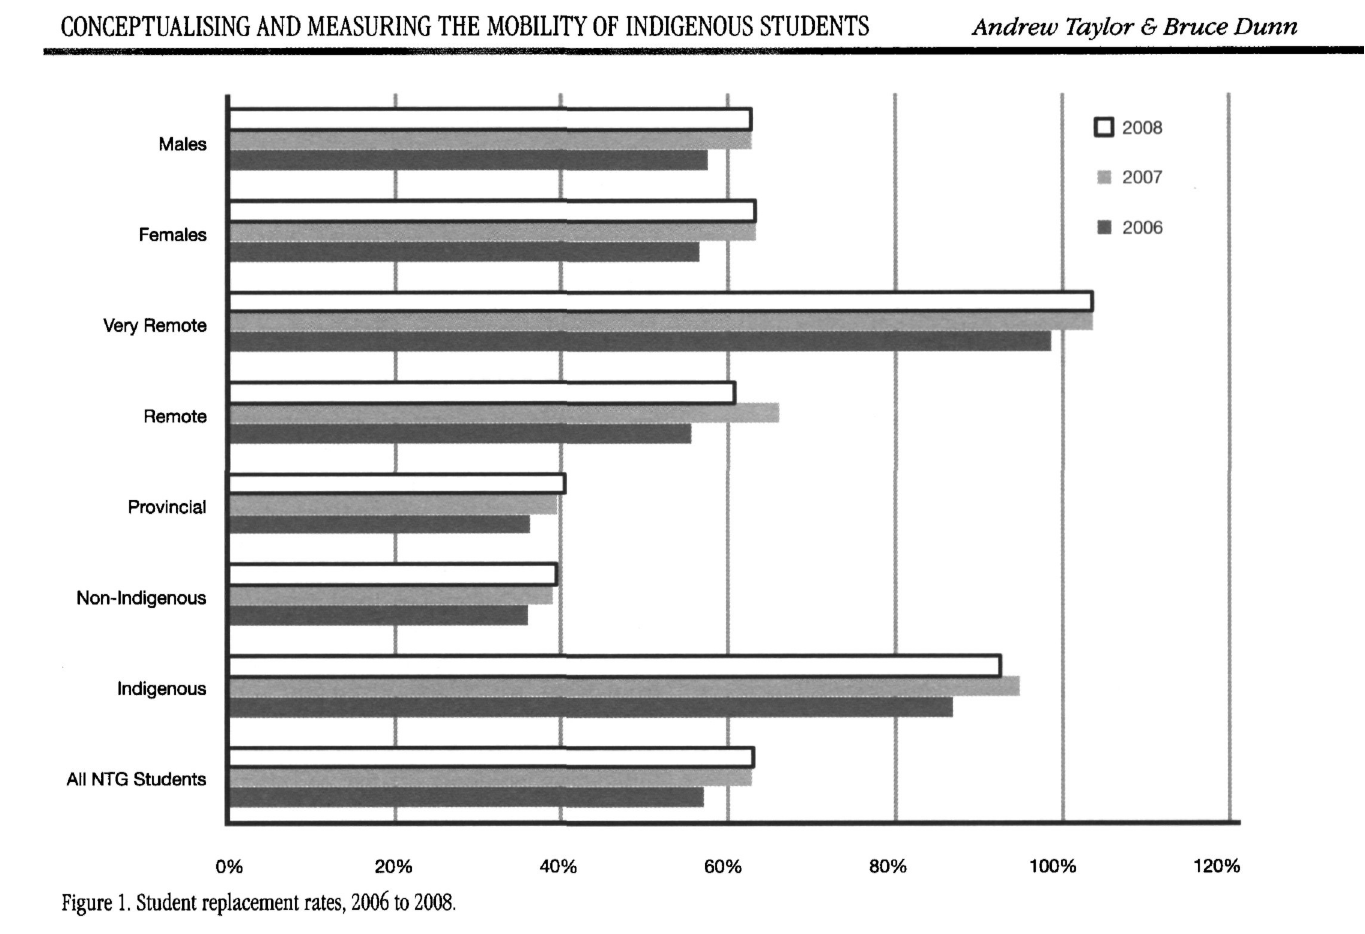
Figure 1. Student replacement rates, 2006 to